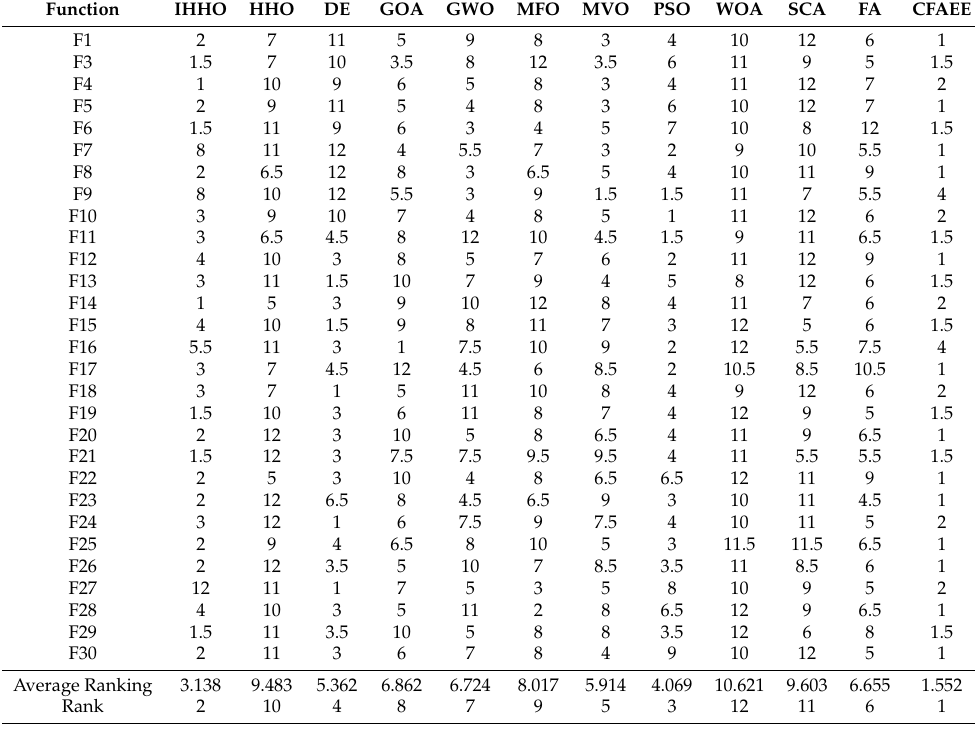
Table 11. Friedman test ranks for the compared algorithms over 30 CEC2017 functions.